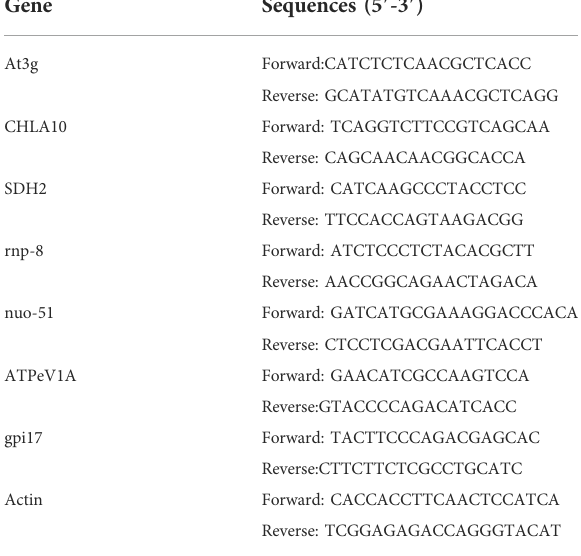
TABLE 1 The primers used for